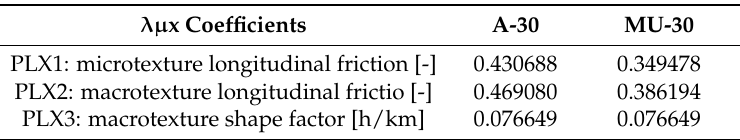
Table 3. Model parameters of the Modified Magic Formula tire.